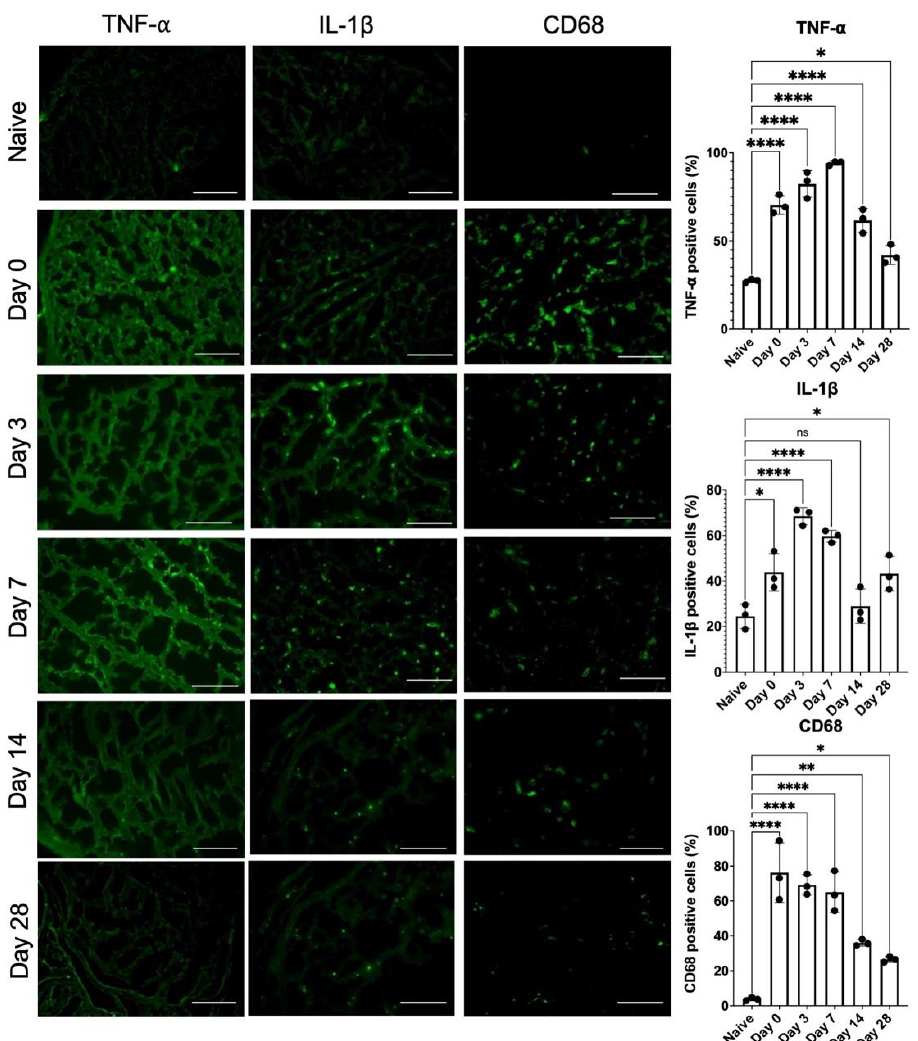
Figure 4. Immunohistochemical staining of injured sciatic nerve for neuroinflammation. Significant increase of signal intensity (TNF- α , IL-1 β and CD68) was induced by nerve constriction injury at day 0, as compared to naïve nerve as baseline. After nerve release, the signal intensity decrease from day 0 to day 28. (n = 3 per timepoint; Naïve nerve: contralateral uninjured nerve; Scale bar: 50 𝜇 m; * indicated p < 0.05, ** indicated p < 0.01, *** indicated p < 0.001, **** indicated p < 0.0001, ns indicated no significant difference)